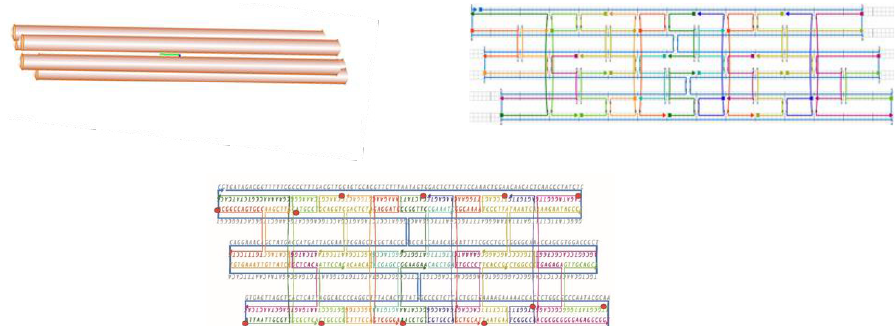
Fig. 2. Graphical view of designed DNTs with caDNAno software and the position of bioten groups